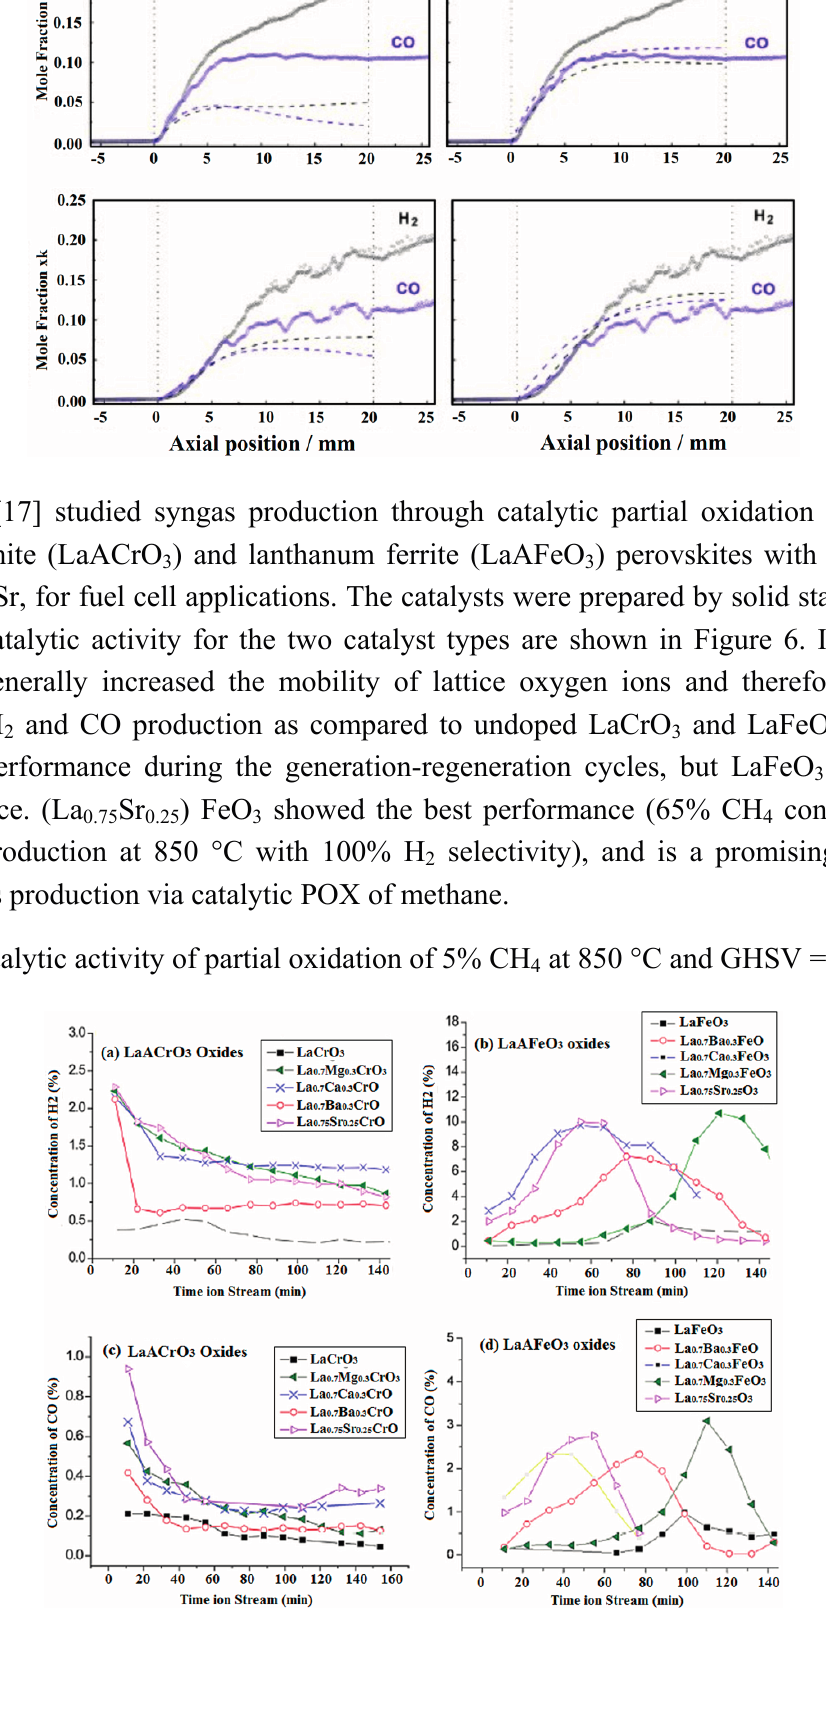
Figure 5. Mole fractions of H 592/296/1112 mln/min and CH